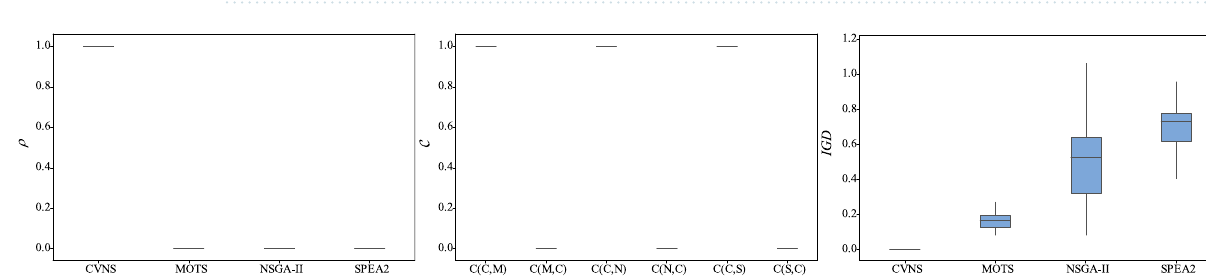
Figure 6. The box plots of three metrics for instances with 3 factories.